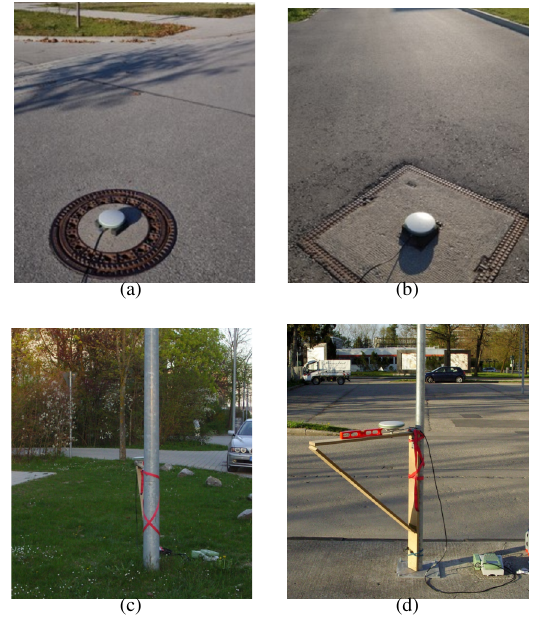
Figure 4. a) and b) Examples of GNSS measurements at check points in test area A; SAR-GCPs c) # 88 and d) # 3568 during validation with GNSS measurements in test area A.